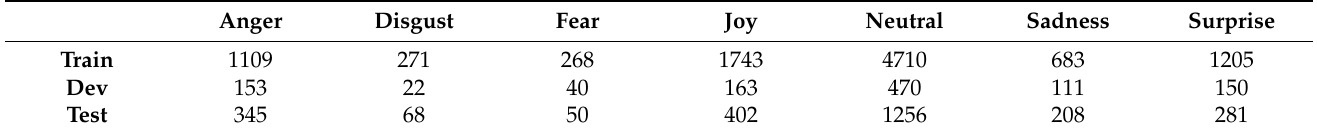
Table 2. Distributions in the training, validation, and test datasets for each